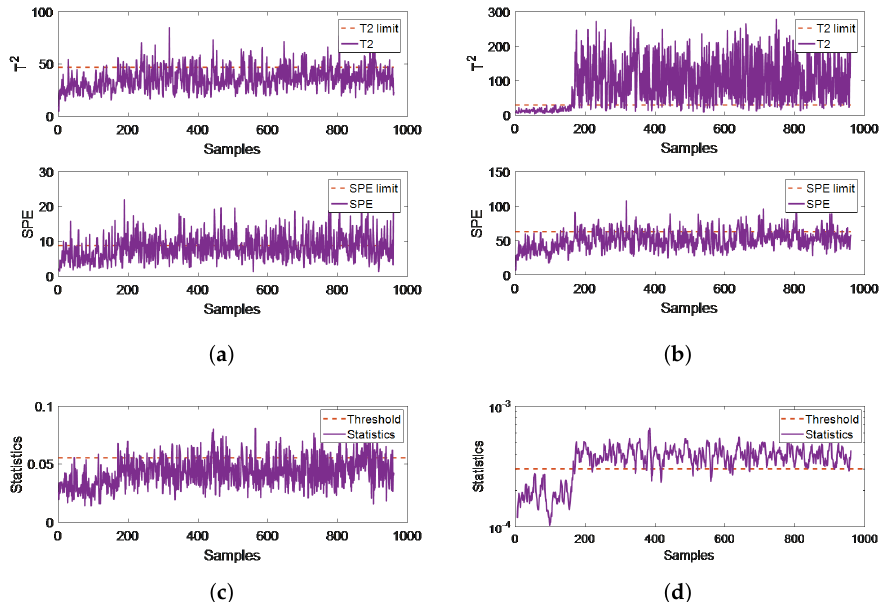
Figure 7. Comparison of detection results for Fault19: ( a ) Fault detection by PCA; ( b ) Fault detection by GLPP; ( c ) Fault detection by SAE; ( d ) Fault detection by DESAE.